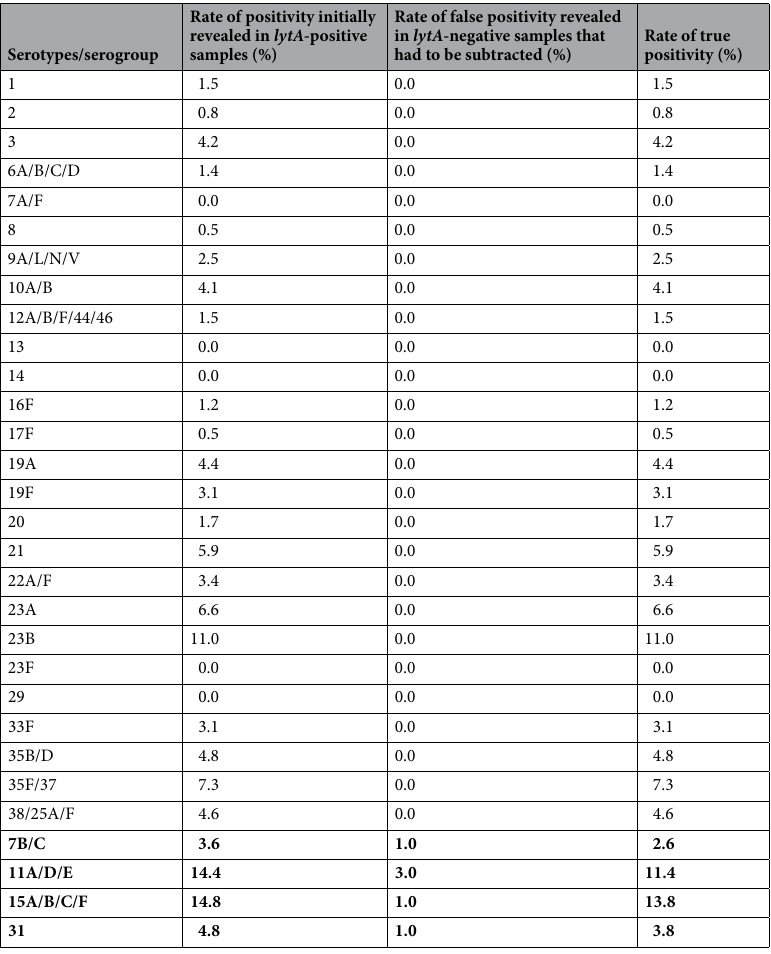
Table 1. Initial and true (final) lytA -positive samples per serotypes/serogroup after subtraction of false positivity